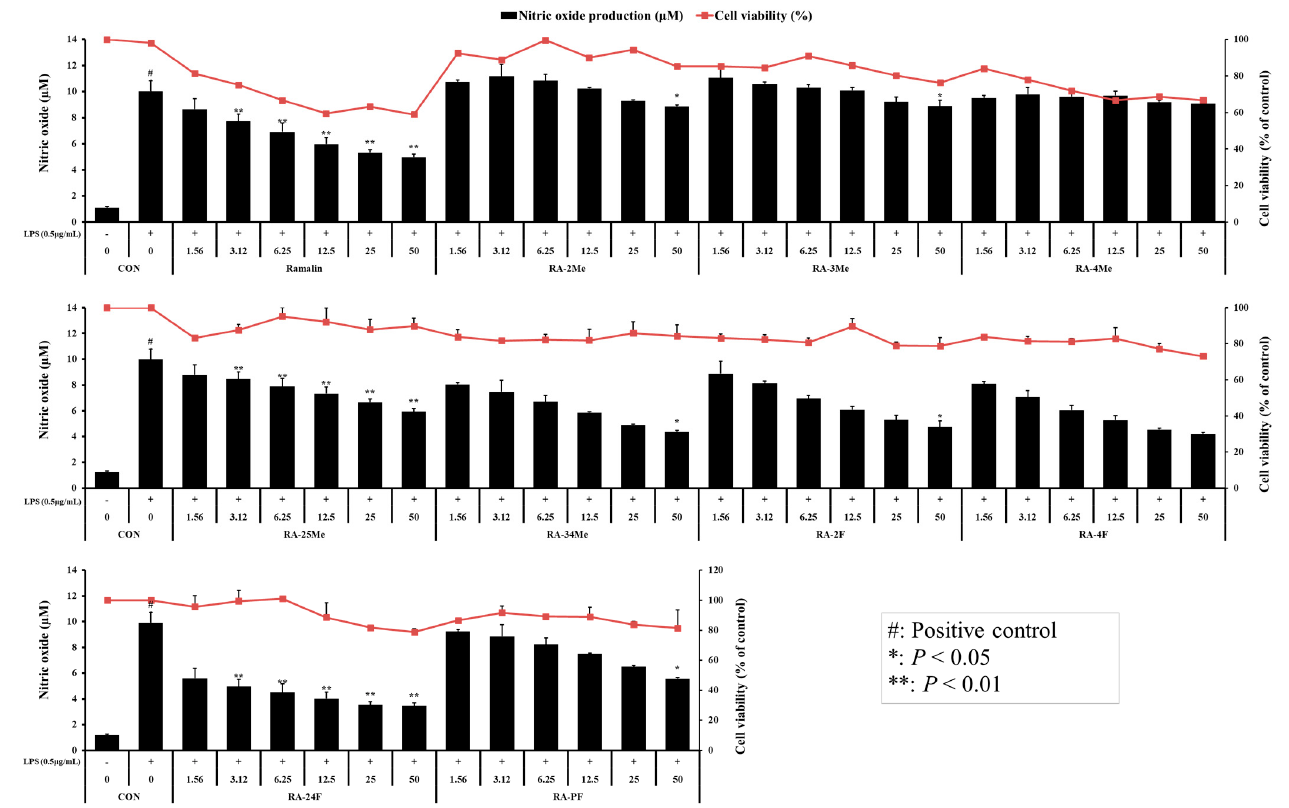
Figure 2. Anti-inflammatory activity and cell viability of ramalin and its derivatives.